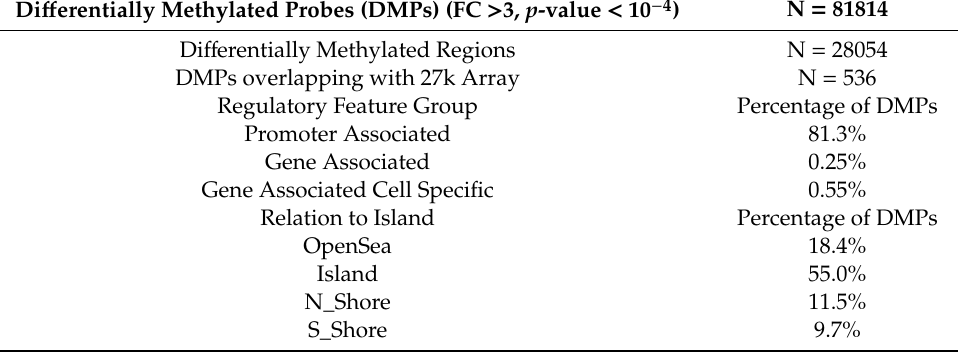
Table 3. Results for the di ff erential expression of methylation probes across TCGA gastric cancer and esophageal